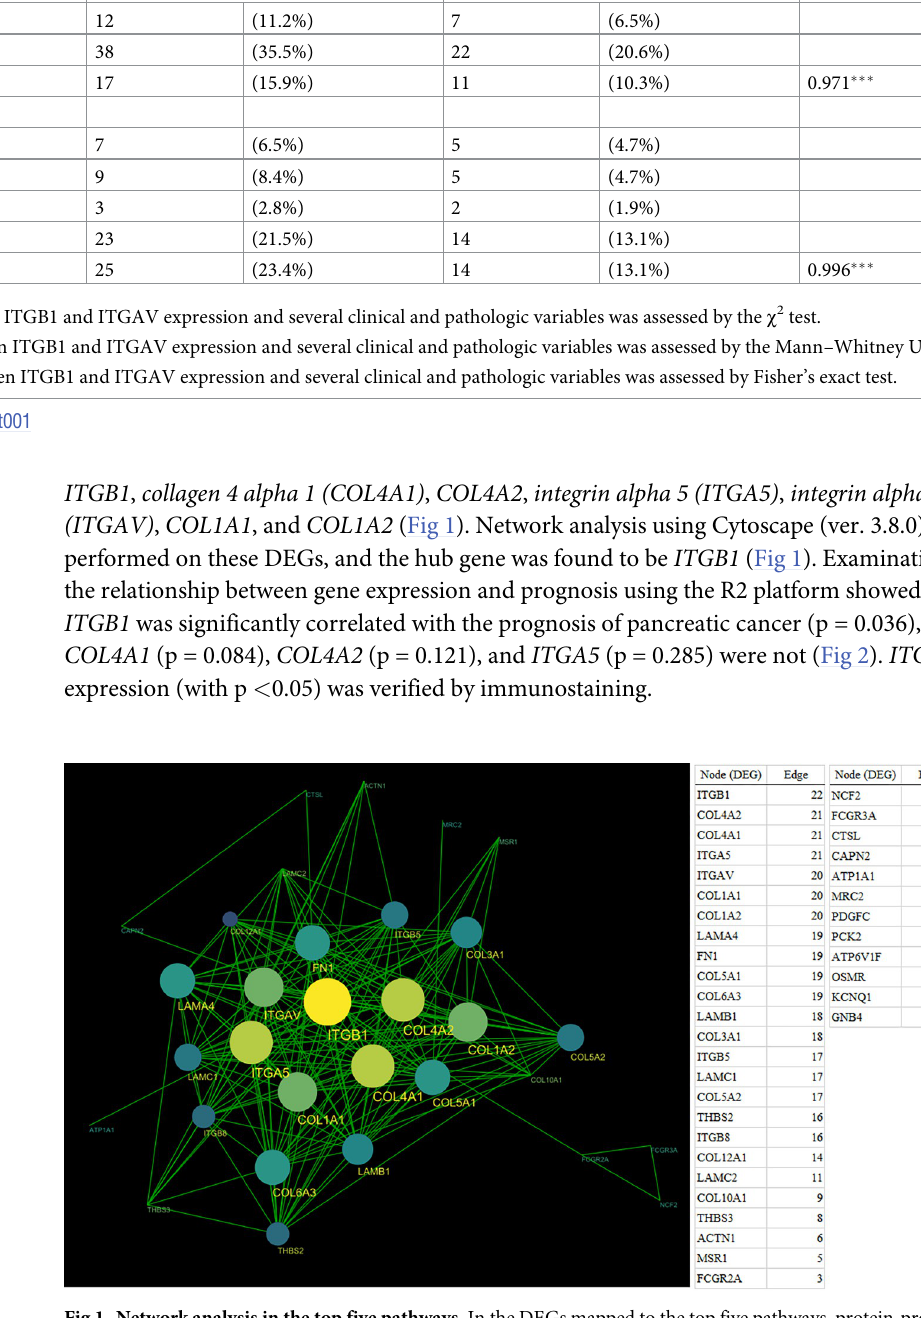
Fig 1. Network analysis in the top five pathways. In the DEGs mapped to the top five pathways, protein-protein interaction analysis was performed, and the network was constructed by Cytoscape (ver. 3.8.0). In this network, the DEGs are called nodes, and the correlated nodes are connected by lines called edges. Furthermore, in this network, the node with the most edges was called the hub gene, suggesting a clinically significant possibility. Second to the top hub genes with 22 and 21 edges, respectively, were selected from the network analysis. ITGB1 , COL4A1 , COL4A2 , and ITGA5 were